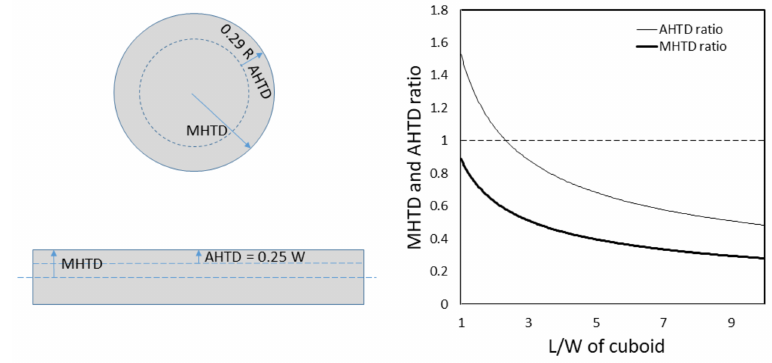
Figure 8. (MHTD cuboid /MHTD column ) and (AHTD cuboid /AHTD column ) ratios as function of the (L/W) ratio of a cuboid packed-bed